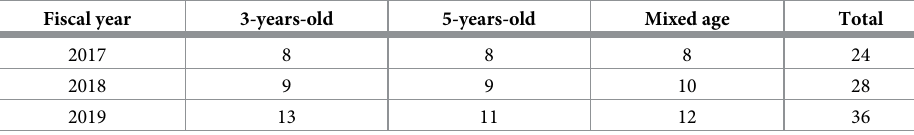
Table 2. The number of classes per age group.